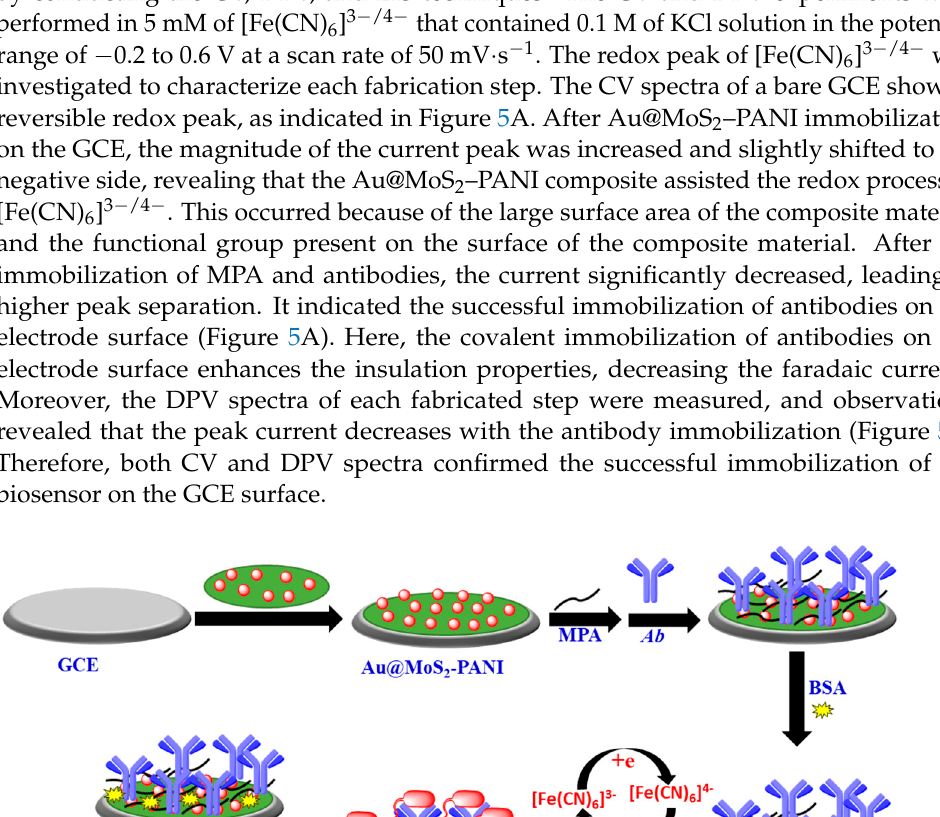
Figure 3. ( A , B ) TEM images of the MoS 2 –PANI composite; ( C , D ) TEM images of AuNPs.